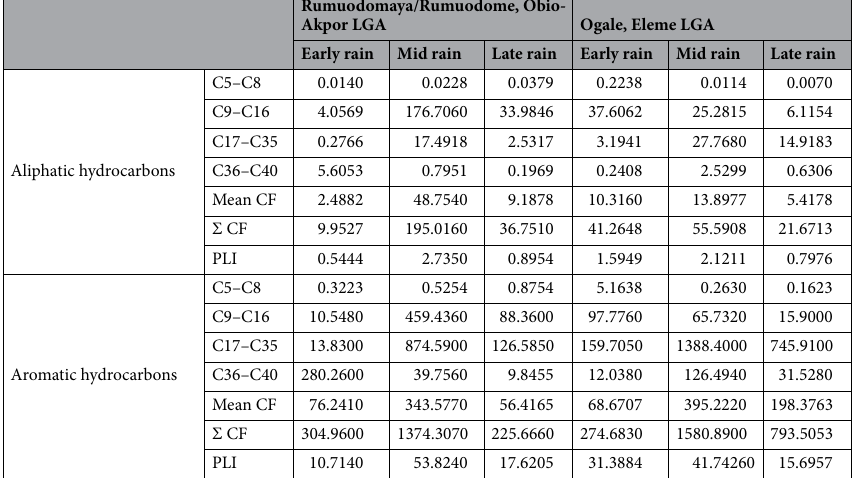
for R/R and Ogale respectively, while the LHC/SHC (even n-alkane) ratio were all significant at all sampling regimen at both study location but mostly pronounced at the early rain (220.33) of R/R area. Table 9 shows average daily intake (ADI) of aliphatic and aromatic petroleum hydrocarbons (PHs) for adults across early rain, mid rain and late rain respectively. For aliphatic PHs, R/R ADI (ingestion) ranged from